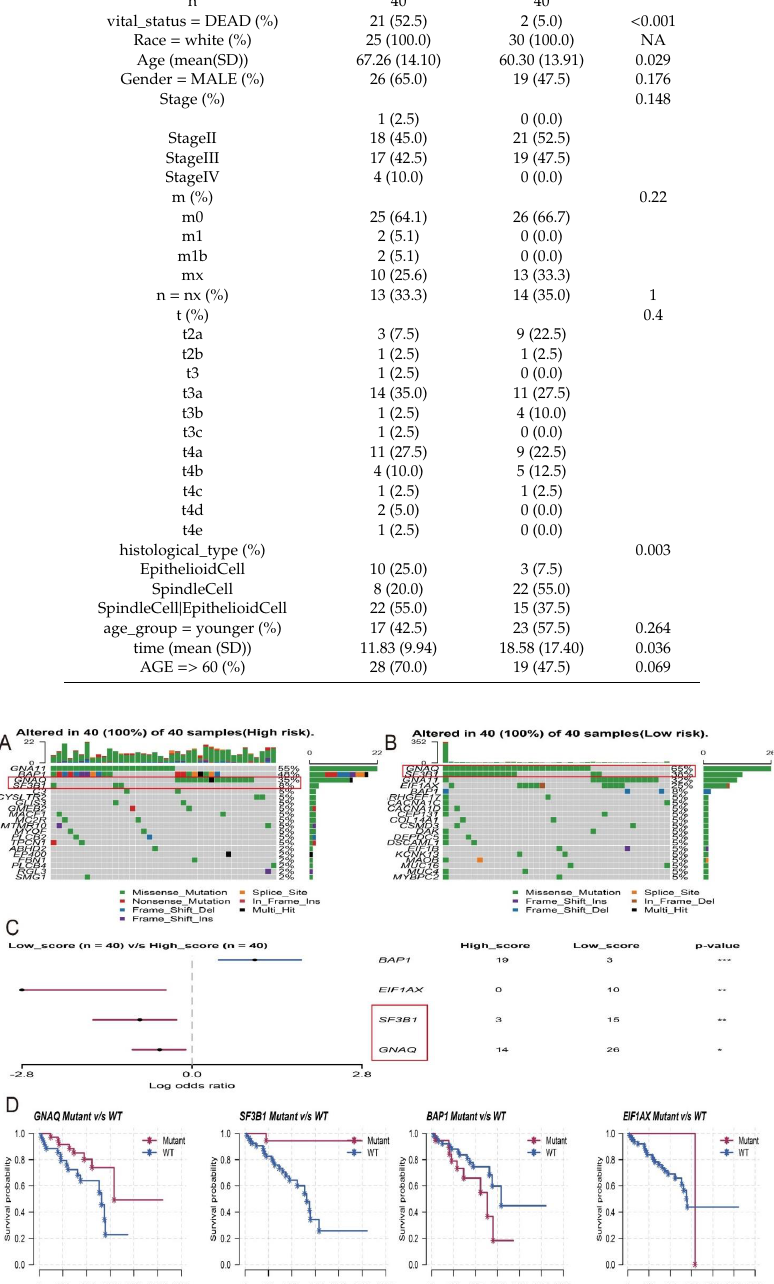
Table 2. The subgroups analysis of clinical characteristics between low- and high- risk groups. The results indicated that UM patients in high-risk have older age, shorter living time and more epithelioid cell type than low-risk (chi-square test p < 0.05). High-risk